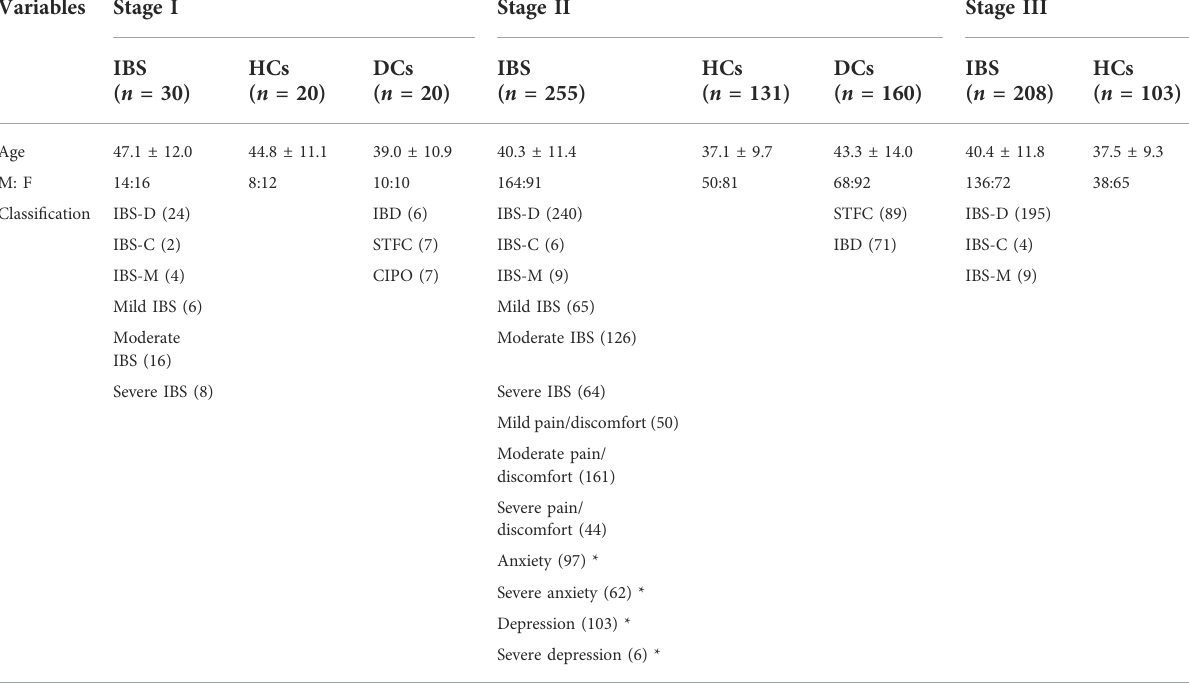
TABLE 1 Demographic data of IBS, HCs and DCs in the three study stages.